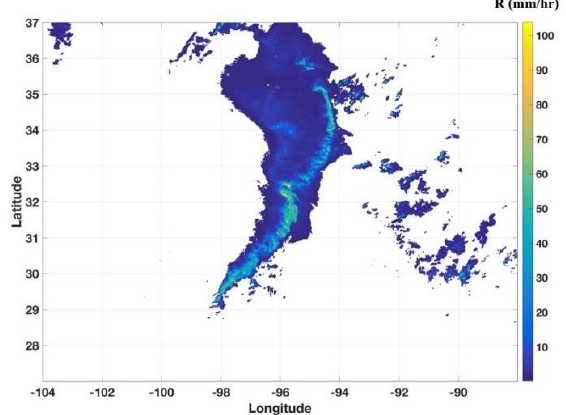
Figure 3. The rainfall rate mosaic at 2210 UTC 25 May 2015.